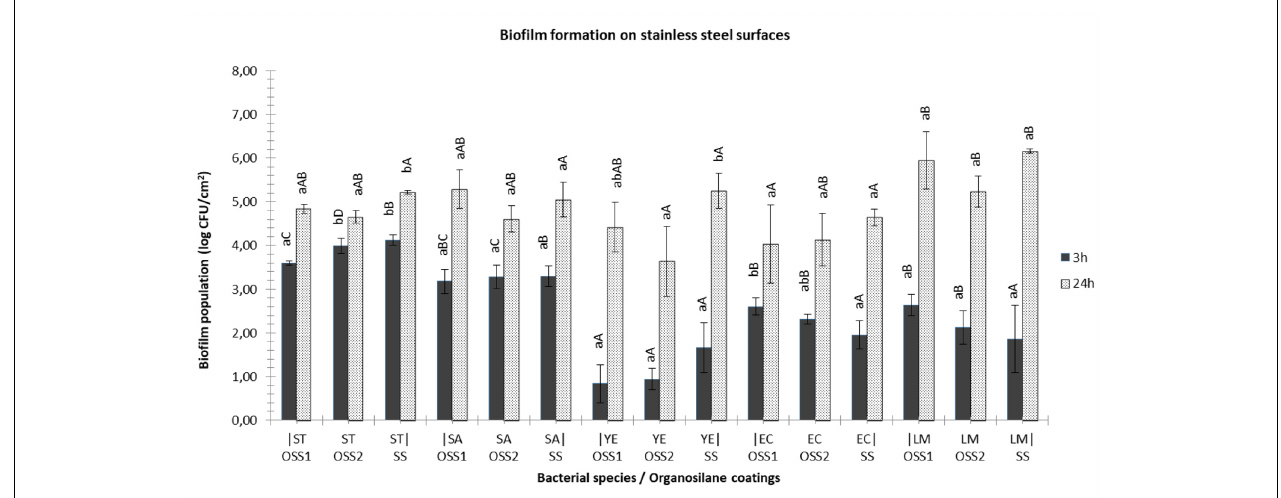
FIGURE 3 | Biofilm formation on glass coupons with (OSS1/OSS2) or without (SS) coating, using two strains of S . Typhimurium (ST), S. aureus (SA), Y. enterocolitica (YE), E. coli (EC) or L. monocytogenes (LM) at 3 h (gray bars) and 24 h (white bars) of incubation at 37 ◦ C. Bars represent means ± standard deviations. Different lowercase letters indicate differences on cells attachment (3 h) or biofilm formation (24 h) according to coating for the same species. Similarly, different uppercase letters point out differences according to species adherence/biofilm formation for the same coated or non-surfaces.